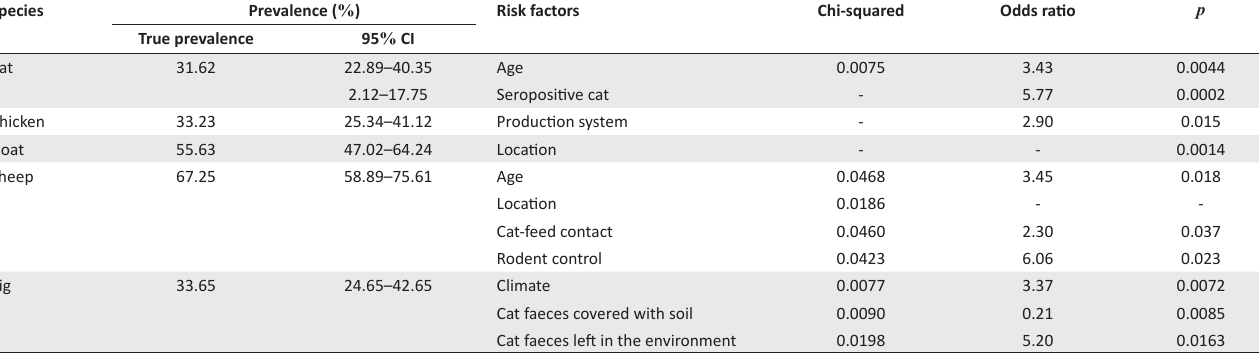
TABLE 1: Seroprevalence of Toxoplasma gondii and statistically significant risk factors in domestic animals in southeastern South Africa (June 2016 – October 2016). Species